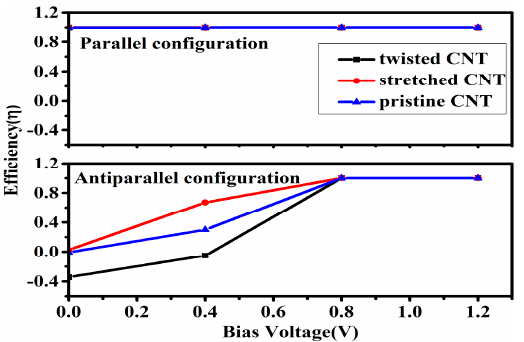
Figure 9. Spin injection factor with respect to applied voltages for all three structures in parallel configuration and antiparallel configuration.